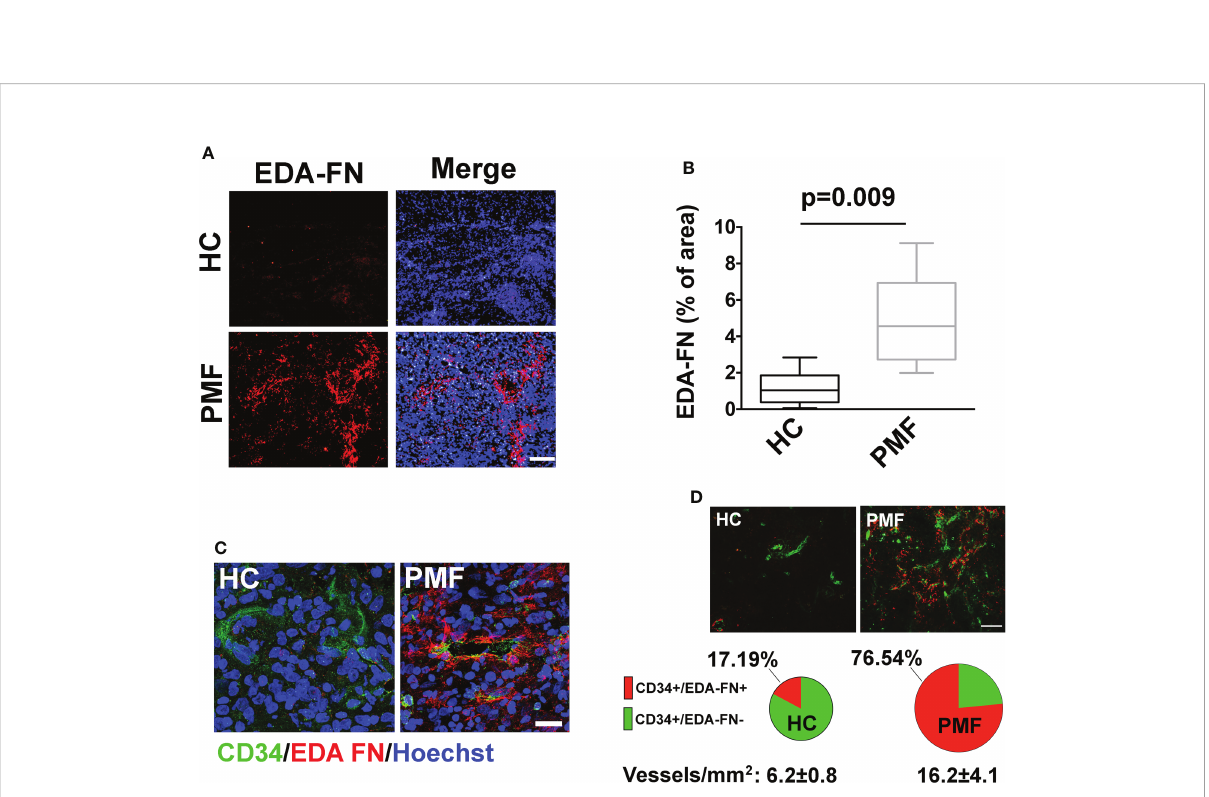
FIGURE 3 EDA-FN is increased in spleen of PMF patients. (A) Confocal microscopy analysis of FN containing EDA segment (Ab IST-9) (red) in spleen biopsies of healthy control (HC) and Primary Myelo fi brosis (PMF) patients. Nuclei were stained with Hoechst 33258. Objective 10x, Scale Bar = 100 m m. (B) EDA-FN immunoreactivity expressed as % of EDA-FN antibody staining area in spleens of HC (N=2) and PMF patients (N=3) normalized on total surface. (C) Confocal microscopy analysis of EDA-FN localization (red) in proximity of CD34+ vessels (green) in spleen sections of HC and PMF patient. Hoechst 33258 was used to stain nuclei. Objective 60x, Scale bar = 50 m m. (D) Quanti fi cation of total CD34+, CD34+/EDA-FN- and CD34+/EDA-FN+ vessels in spleen biopsies of HC (N=2) and PMF patients (N=3). At least 10 fi elds per sample were analyzed. Objective 20x, Scale bar = 100 m m.